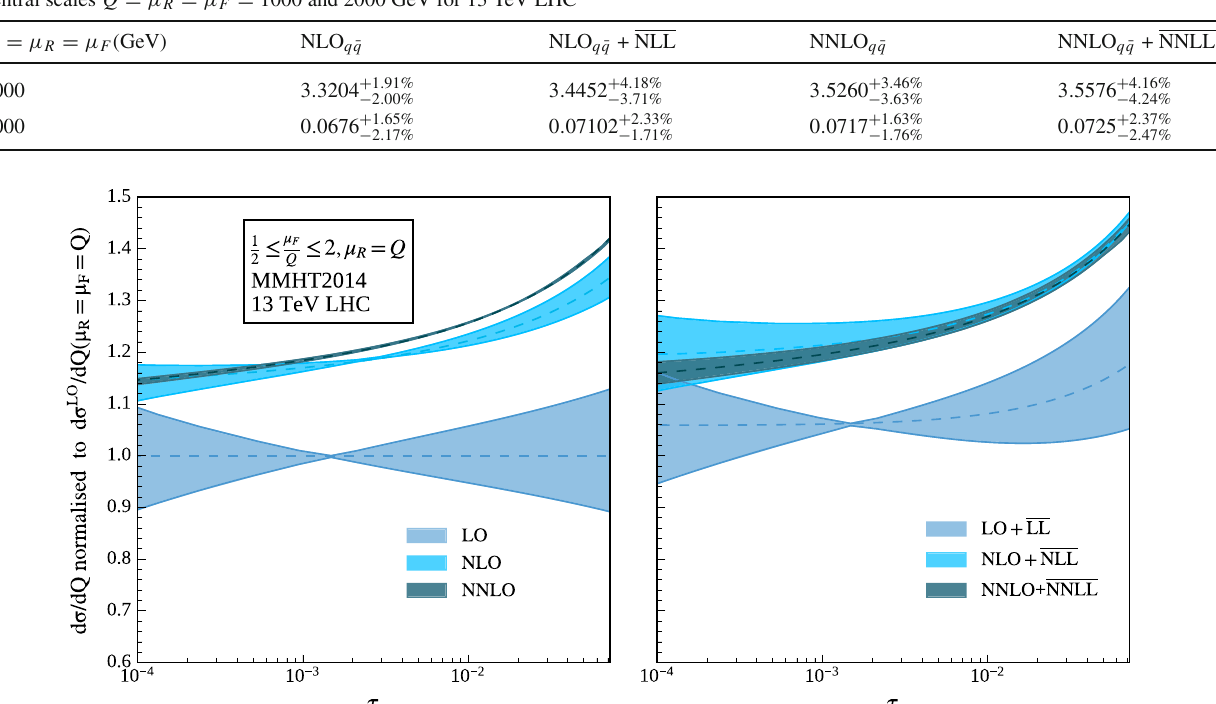
Fig. 5 μ F scale variation of the resummed results against the fixed-order with the scale μ R held fixed at Q for 13 TeV